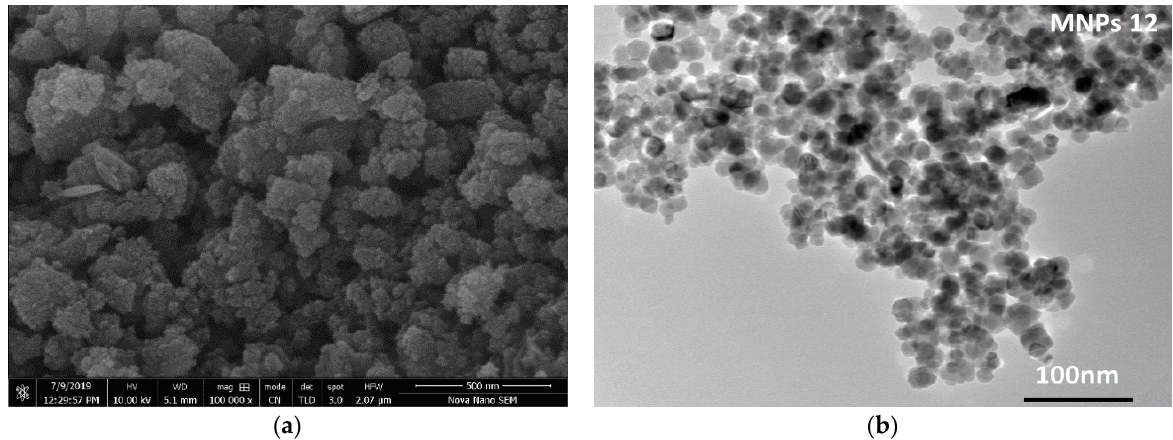
Figure 2. SEM ( a ) and TEM ( b ) micrographs shows the surface morphology of Fe 2 O 3 NPs.